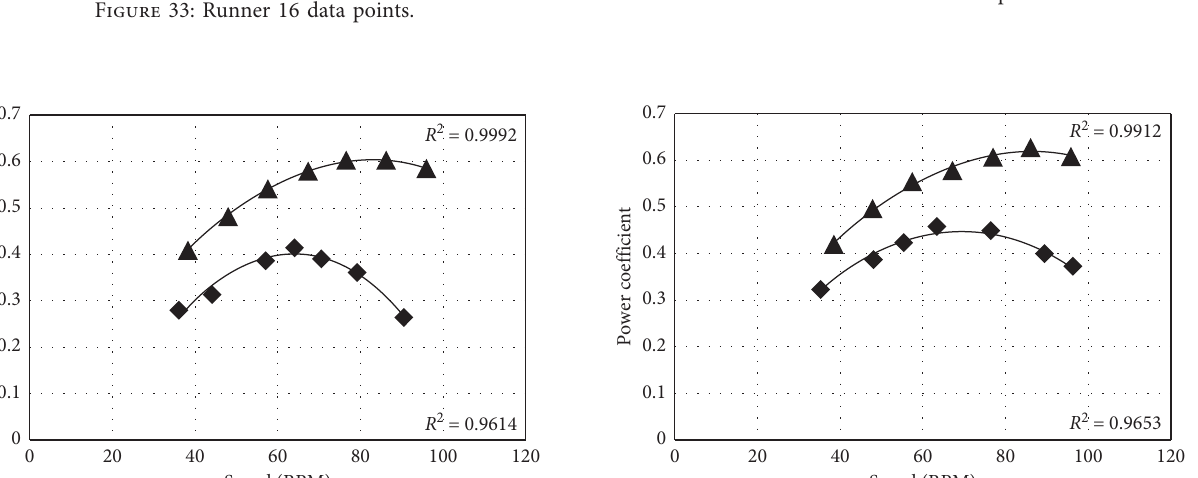
Figure 33: Runner 16 data points.